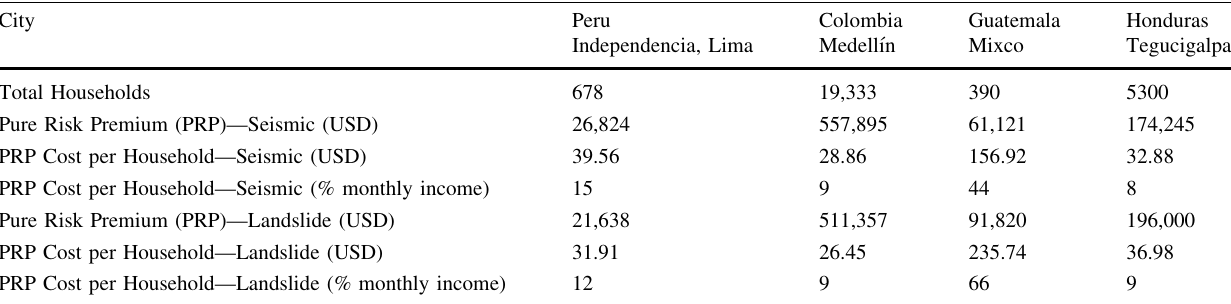
Table 6 Pure risk premium per household